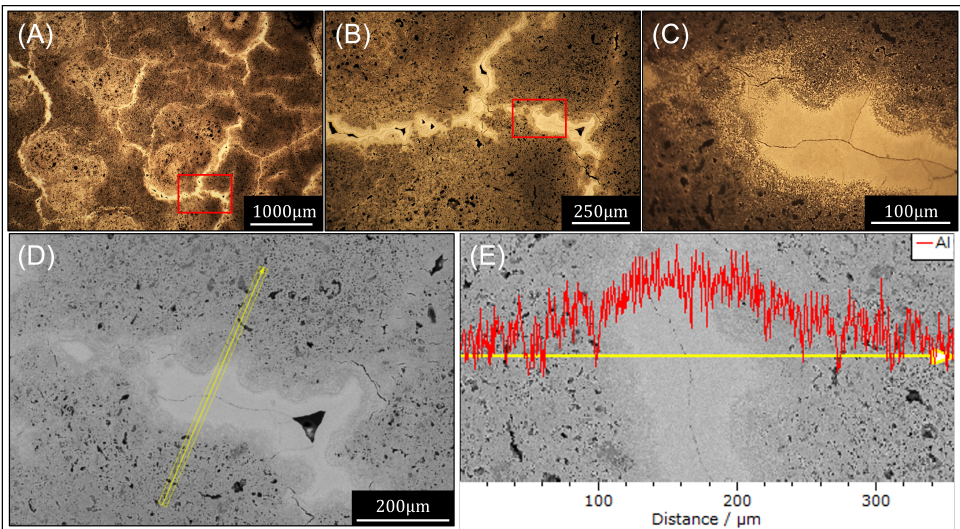
Figure 6. Effects of nitriding at temperatures ≥ 550 °C: ( A – C ) optical image showing bright thin metallic bands dispersed throughout the agglomerated AlN sample and ( D – E ) SEM-EDS line profile scan across a metallic band showing the high detection of